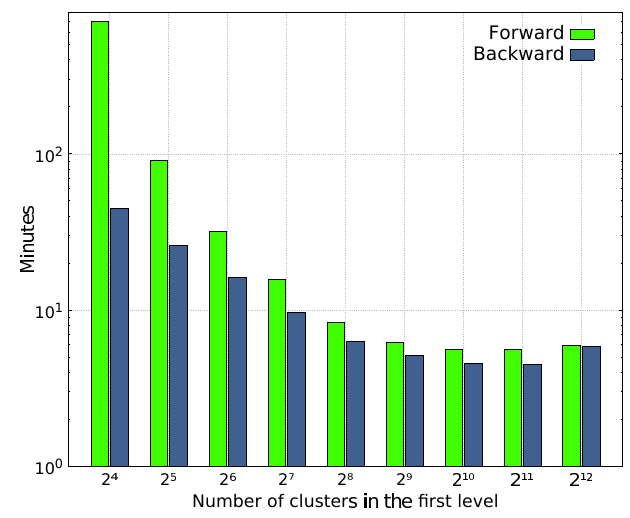
Figure 10. Runtime comparison in minutes for different cluster sizes of Multilevel Clustering RKLT applied to an IASI L1C orbit with 2 13 spectral channels and a spatial resolution of 765 × 30 × 4 (number of scan lines × number of FORs per line × number of IFOVs per FOR). The dissemination granularity of the data is 3 min for Level 1c [70].